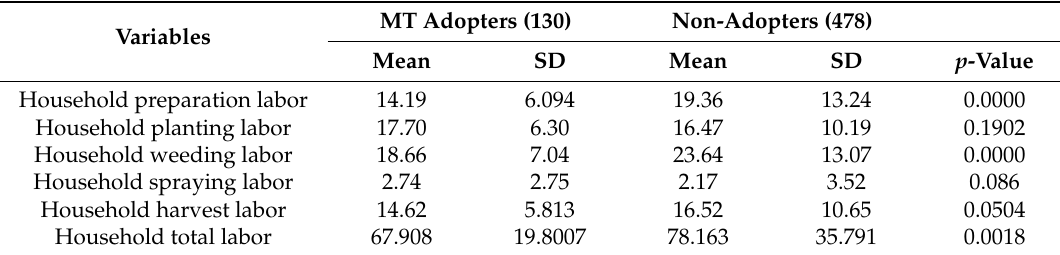
Table 2. Household labor demands by tillage.